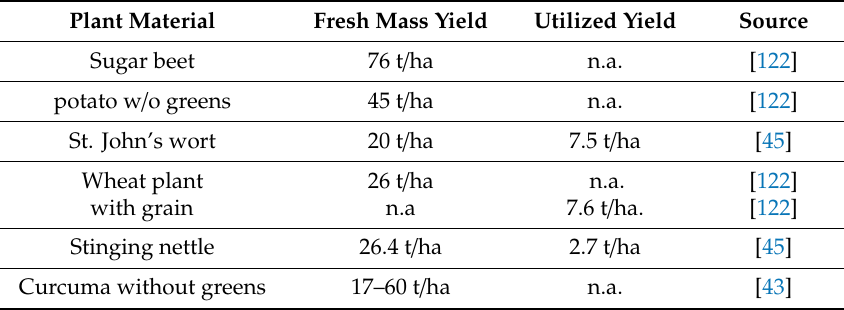
Table 3. Agricultural yield for selected field